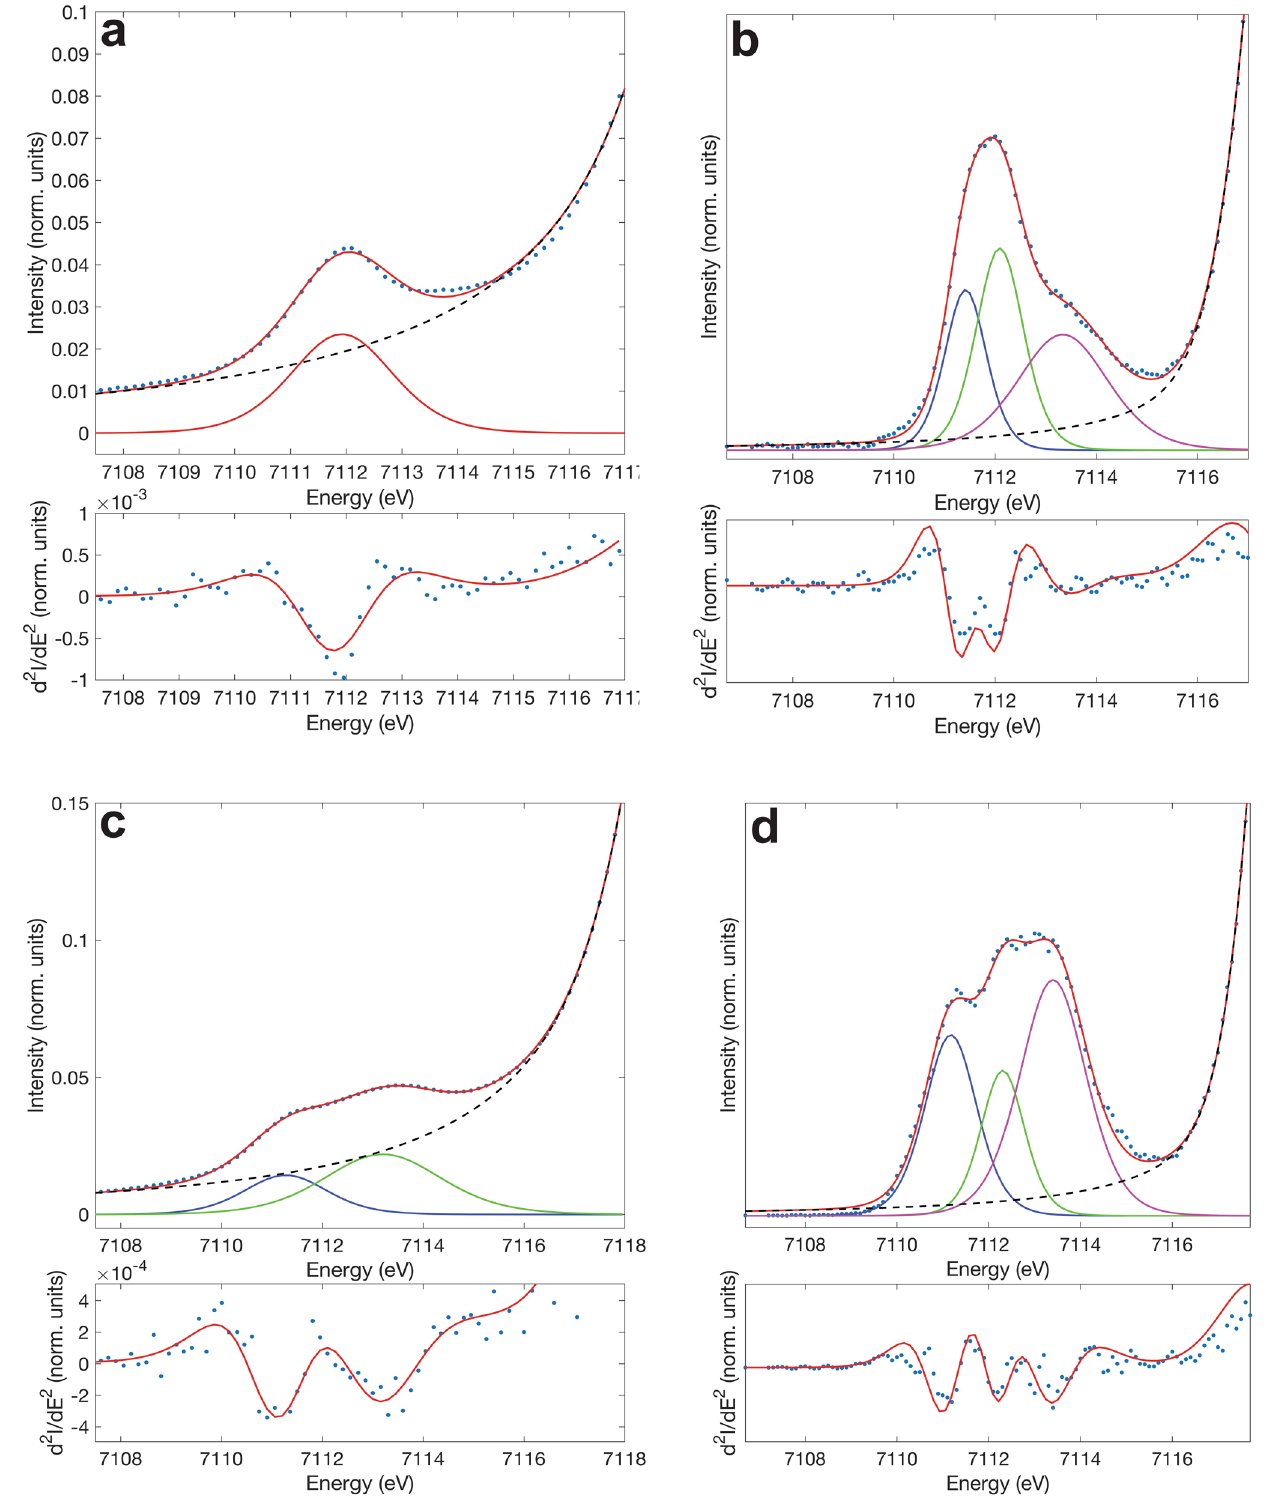
Fig. 6 Fe-XANES and Fe HERFD-XANES recorded for the [FeCo] crystals. a Upper fi gure: Fe-XANES pre-edge measured at 8 K (blue circles), fi t to the rising edge (broken black line) and total fi t (solid red line). Lower fi gure: second derivative of Fe-XANES measured at 8 K (blue circles) with related fi t (solid red line). b Upper fi gure: Fe HERFD-XANES measured at 8 K (blue circles), fi t to the rising edge (broken black line), individual peak fi ts (solid lines, blue, green, magenta) and total fi t (solid red line). Lower fi gure: second derivative of Fe HERFD-XANES measured at 8 K (blue circles) with related fi t (solid red line). c Upper fi gure: Fe-XANES pre-edge measured at 250 K (blue circles), fi t to the rising edge (broken black line), individual peak fi ts (solid lines, blue, green) and total fi t (solid red line). Lower fi gure: second derivative of Fe-XANES measured at 250K (blue circles) with related fi t (solid red line). d Upper fi gure: Fe HERFD-XANES measured at 250 K (blue circles), fi t to the rising edge (broken black line), individual peak fi ts (solid lines, blue, green, magenta) and total fi t (solid red line). Lower fi gure: second derivative of Fe HERFD-XANES measured at 250 K (blue circles) with related fi t (solid red